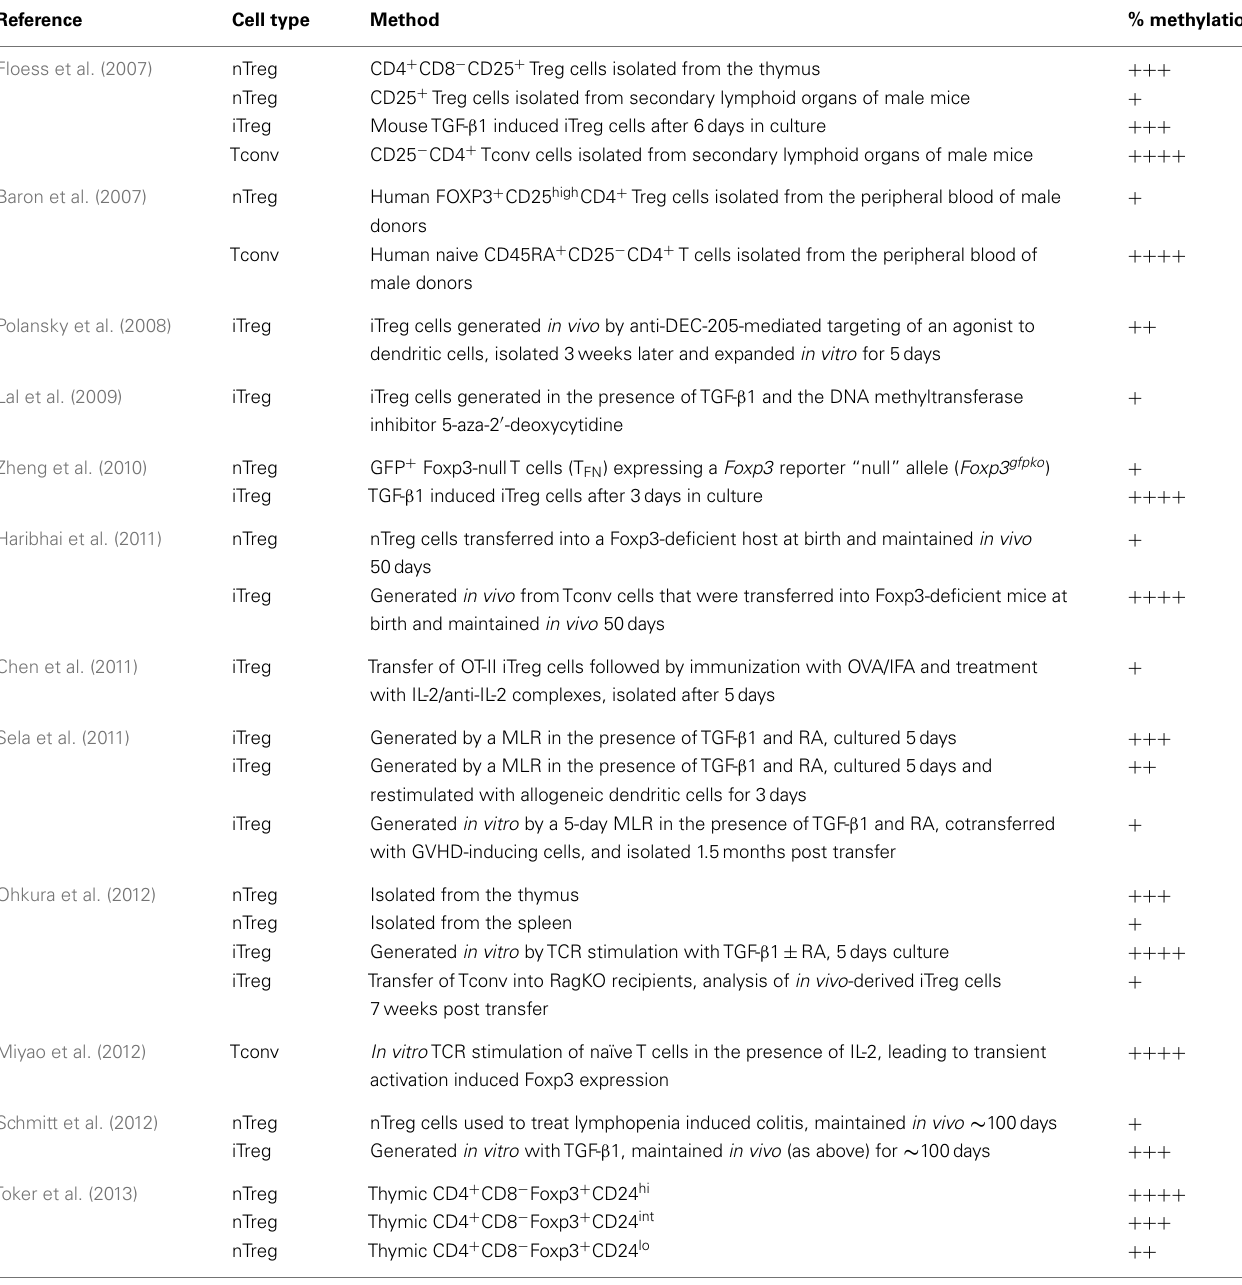
This table documents the percent methylation of CNS2, also known as theTreg cell-specific demethylated region (TSDR), of nTreg, iTreg, andTconv cells in several differentmodelsystems andorgans. Percentmethylationisdepicted asfollows: + ,0–25% methylated; ++ ,25–50%methylated; +++ ,50–75% methylated; ++++ , 75–100% methylated. GVHD, graft versus host disease; IFA, incomplete Freud’s adjuvant; MLR, mixed leukocyte reaction; OVA, ovalbumin; RA, retinoic